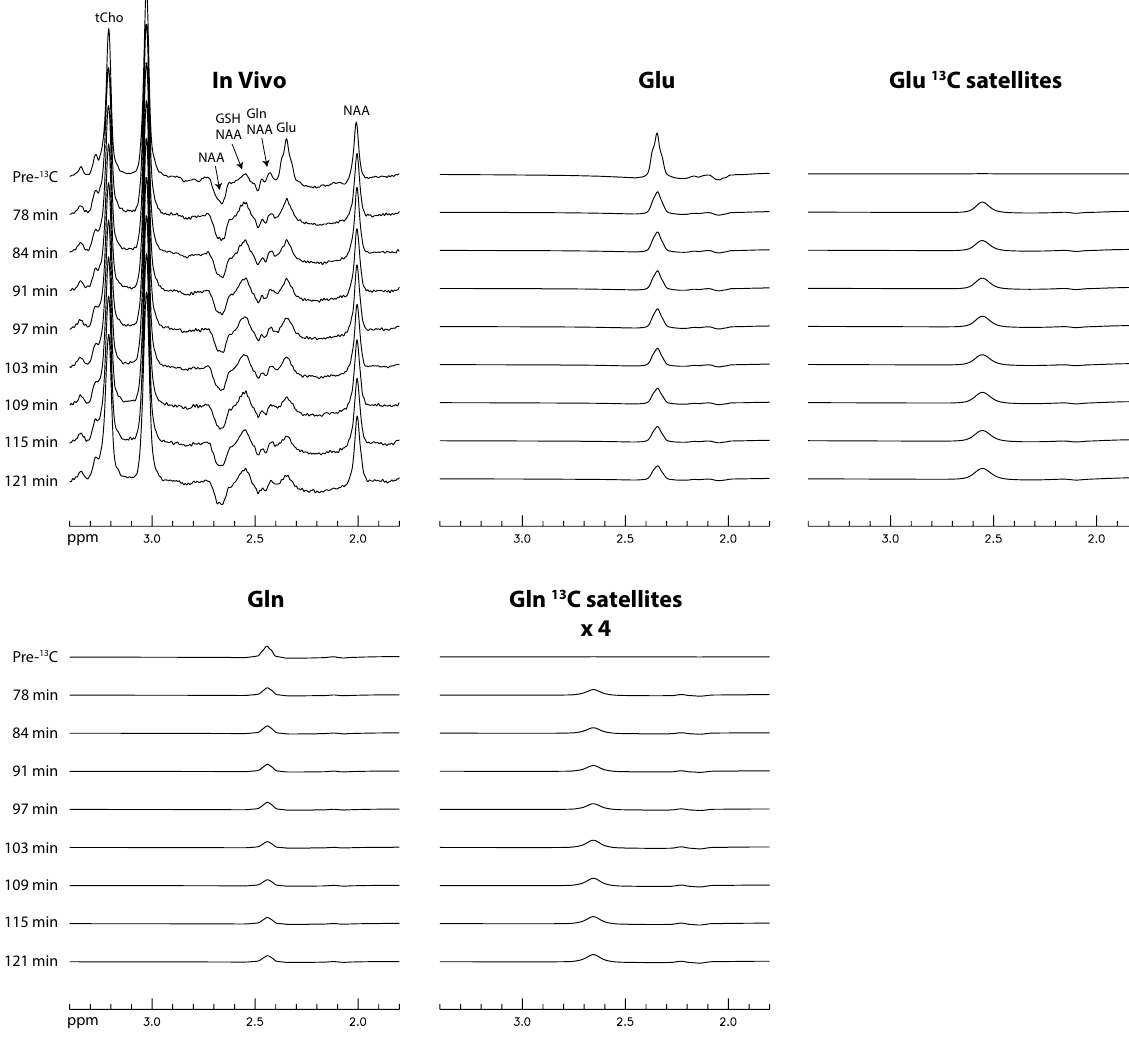
Figure 3. Time-course spectra and corresponding fitted spectra of Glu, Gln, and their 13 C satellites acquired from the dACC of a representative participant. The spectra for Gln 13 C satellites have been scaled up vertically by a factor of